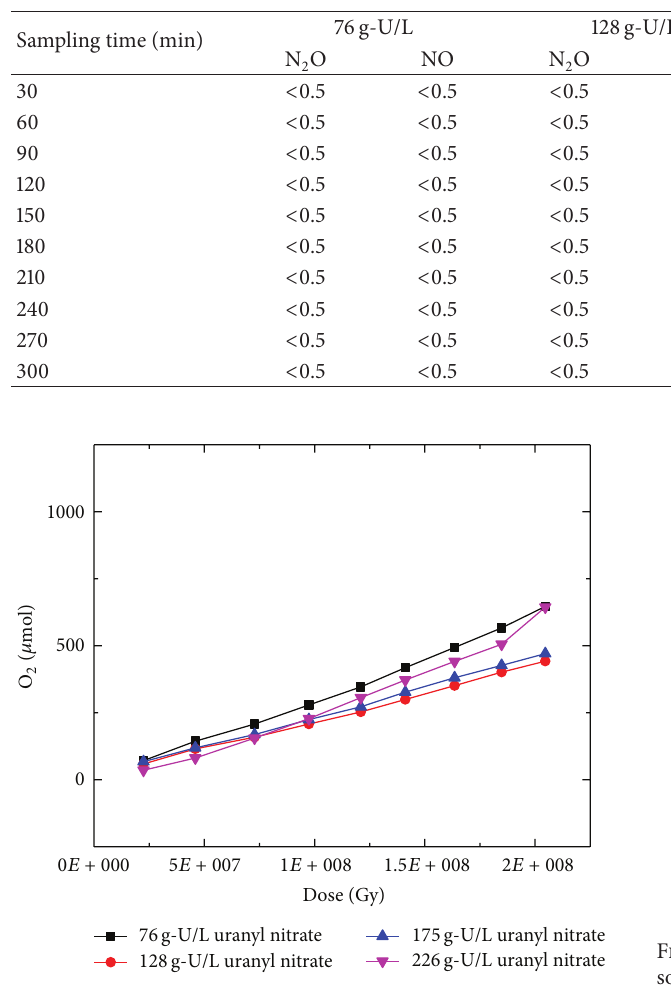
Figure 3: Oxygen evolution measured during irradiation of UO 2 (NO 3 ) 2 solutions at the Van de Graaff.